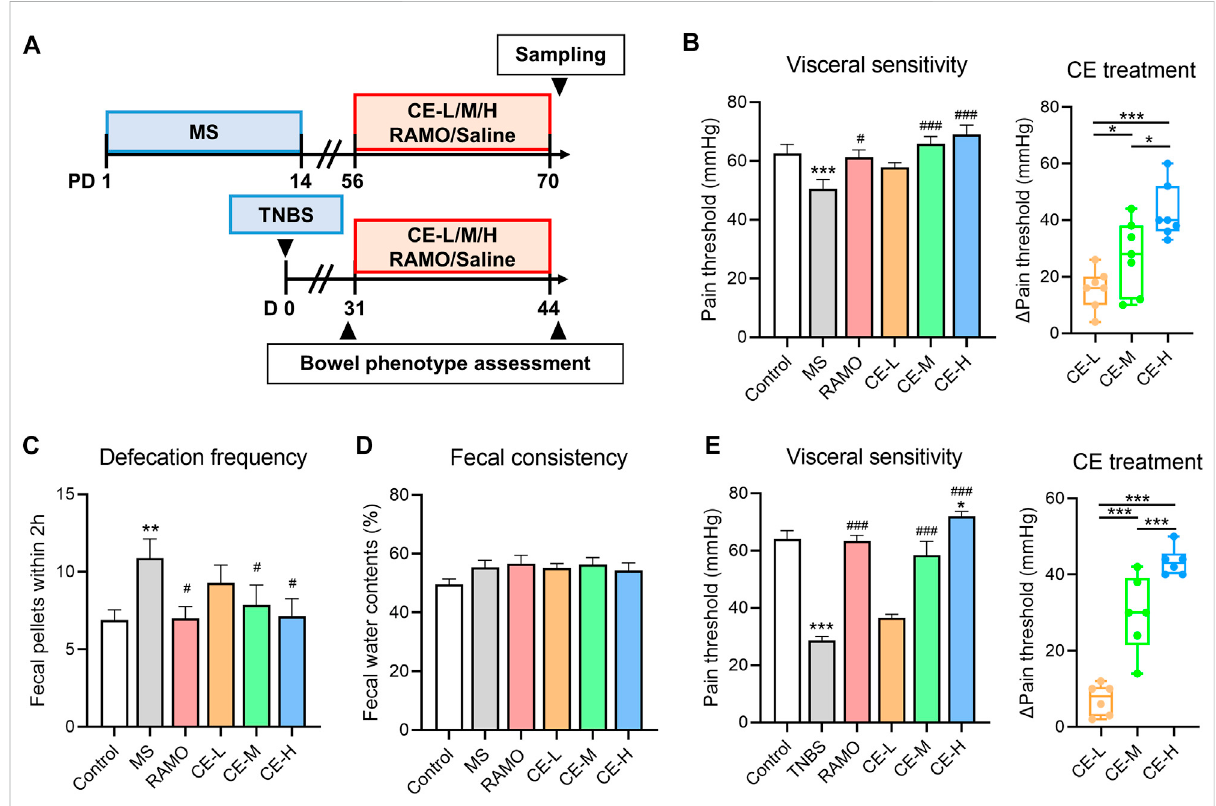
FIGURE 1 Cinnamon extract (CE) ameliorates bowel symptoms in maternally separated (MS) or 2,4,6-trinitrobenzene sulfonic acid (TNBS)-induced IBS rats (A) Timeline of drug interventions and assessments in rat models. MS rats (n = 7 – 8/group) were individually treated with saline, Ramosetron (.03 mg/kg/d), low (30 mg/kg/d), medium (90 mg/kg/d), or high doses (270 mg/kg/d) of CE for 14 consecutive days while rats without MS handling (n = 8) were used as controls (B – D) Bowel phenotypes, including visceral sensitivity, defecation frequency, and fecal consistency of MS rats receiving different interventions (E) Visceral sensitivity of control and TNBS rats receiving different interventions (n = 6 – 8/group). One way ANOVA analysis was used for statistics and signi fi cance was expressed by *, p < .05; **, p < .01; ***, p < .005 compared with the control group or within CE groups; #, p < .05; ##, p < .01; ###, p < .005 compared with the model